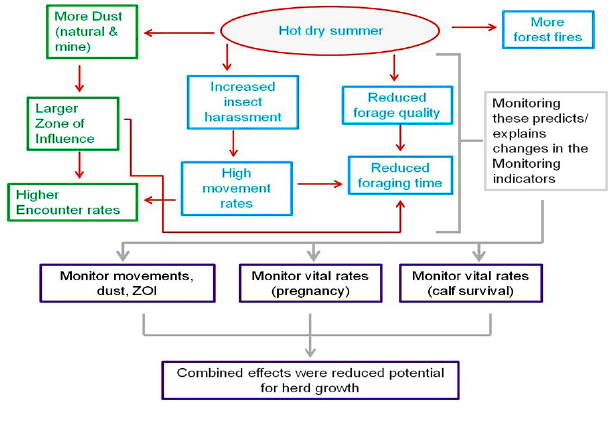
Fig. 5. Probable effects of an environmental change (hot, dry summer) and its direct effects on caribou behavior and on project-specific